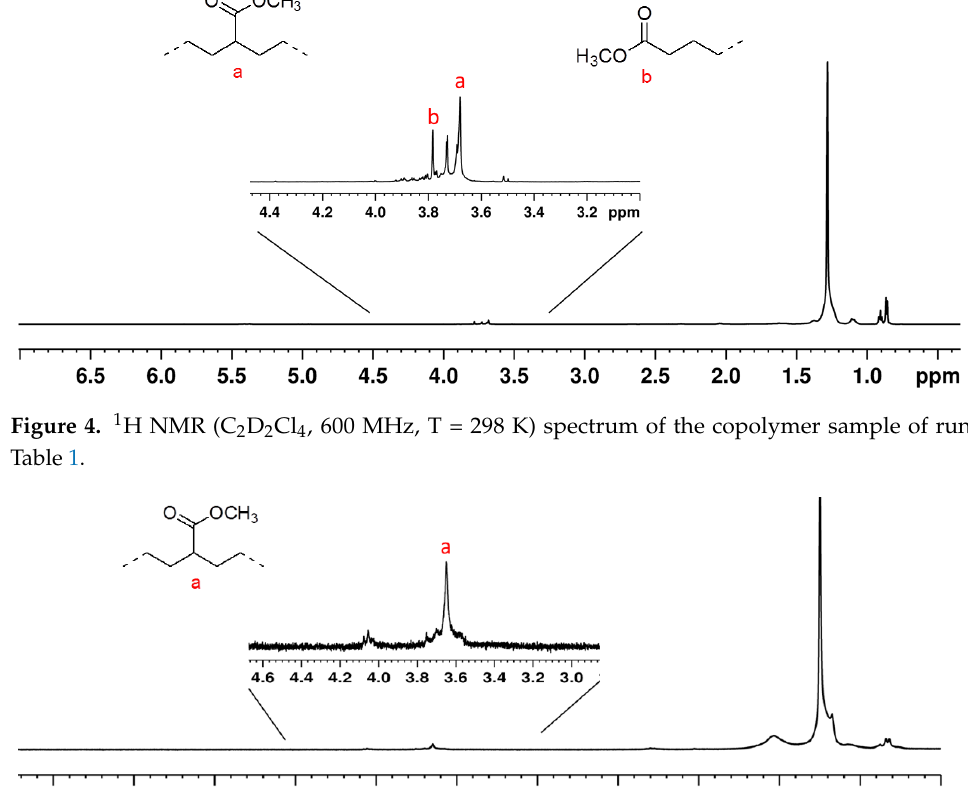
Figure 5. 1 H NMR (CDCl 3 , 300 MHz, T = 298 K) spectrum of the pentane-insoluble fraction of the copolymer sample of run 3, Table 1.